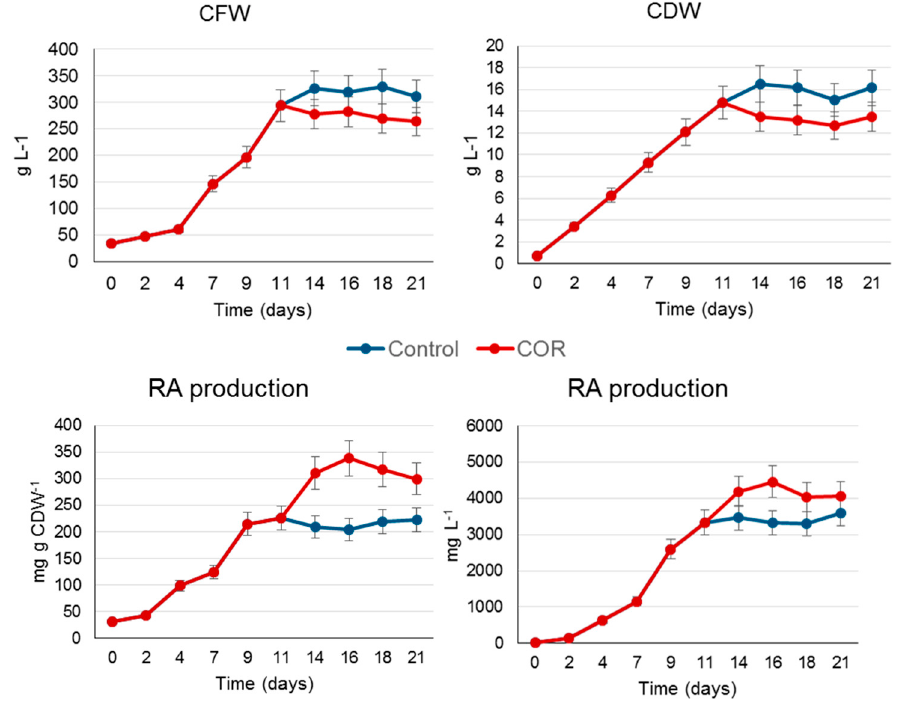
Figure 2. Biomass measured as cell fresh weight (CFW) and dry cell weight (CRW), and rosmarinic acid (RA) production in S. khuzistanica control and COR-elicited cultures in a benchtop bioreactor during a growth period of 21 days. The data are the average of two replicates ± SD.